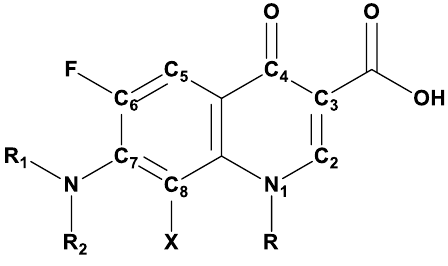
Figure 4. General fluoroquinolone (FQ) structure (X = H or F; carboxylic acid group, pk a1 , alkaline amine functional groups, pk a2 ).